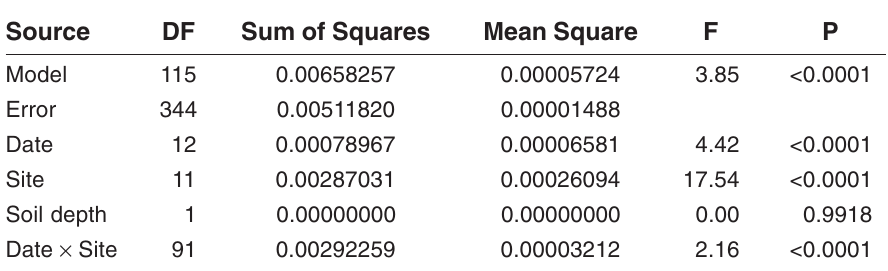
Analysis of Variance Results Using GLM Procedure for